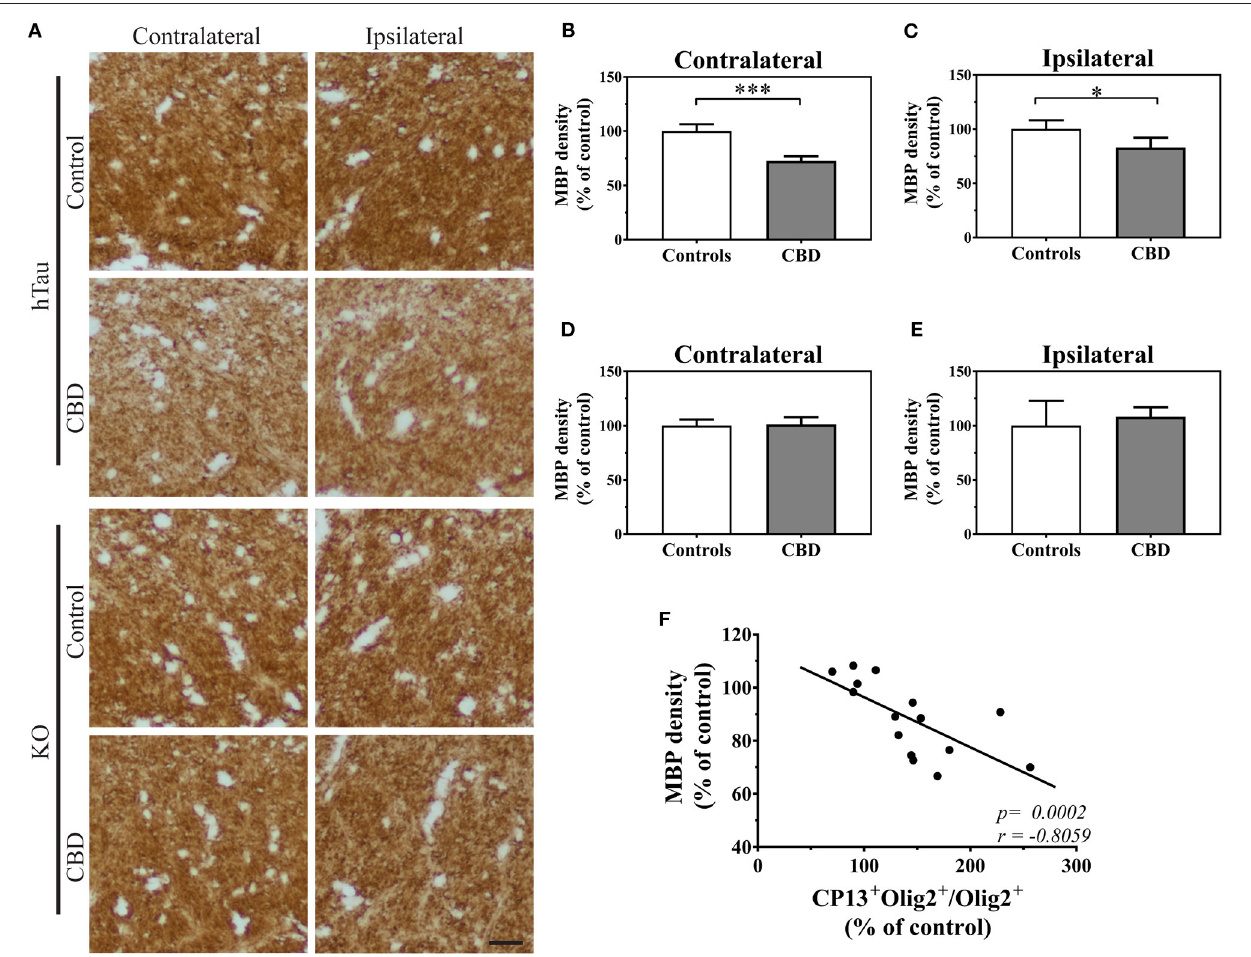
FIGURE 2 | The functional changes in oligodendrocytes triggered by CBD-tau inoculation. (A) , the corpus callosum microphotography pictures of myelin basic protein (MBP) immunoreactivity in the contralateral (left panel) and ipsilateral (right panel) sides in hTau (upper panel) or KO (lower panel) animals 12 months after control-tau (upper subpanel) or CBD-tau (lower sub panel) injection. The scale bar represents 25 µ m and applies to all pictures. (B–E) , The quantitative analysis of densitometric data of MBP immunoreactivity in the corpus callosum of hTau animals contralateral ( B, controls n = 4, CBD n = 4) and ipsilateral ( C, controls n = 4, CBD n = 4) hemispheres; and KO animals contralateral ( D, controls n = 3, CBD n = 4) and ipsilateral ( E, controls n = 3, CBD n = 4) hemispheres. The significant decrease in MBP densitometry was observed bilaterally only in hTau animals, reflecting presence of tau-dependent changes. (F) , correlation of MBP density and double-positive oligodendrocytes in the corpus callosum. The presence of significant positive correlation indicates functional changes in oligodendrocytes upon tau pathology presence. Comparison between two groups was performed using the Student t test. Spearman’s rank correlation coefficient was used to analyze dependence between two sets of data. P -value < 0.05 was considered statistically significant. * P < 0.05, *** P < 0.0001.